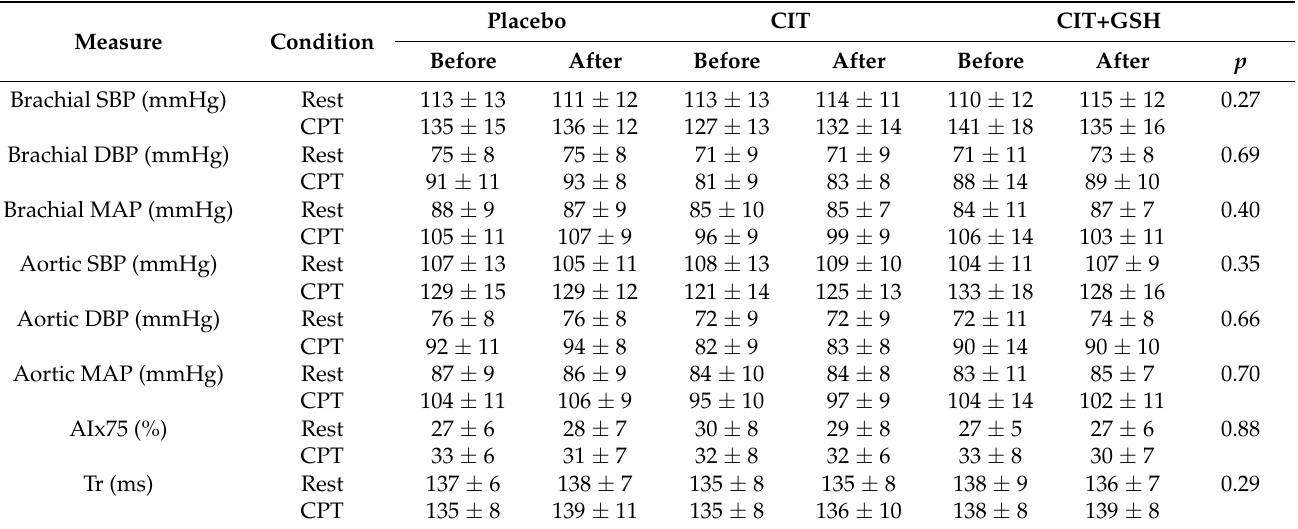
Values are the mean ± SD. Abbreviations: AIx, augmentation index normalized to the heart rate of 75; CIT, cit- rulline; CIT+GSH, CIT+glutathione; DBP, diastolic blood pressure; MAP, mean arterial pressure; SBP, systolic blood pressure; Tr, reflection time. p -values of ANOVA time-by-group